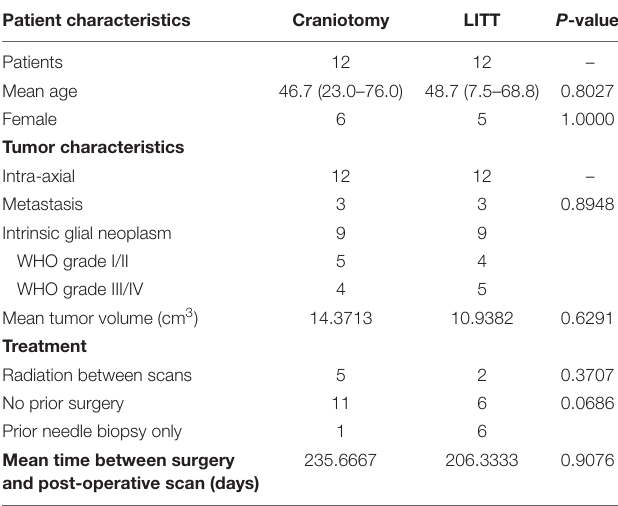
TABLE 1 | Baseline characteristics of craniotomy and laser interstitial thermal therapy